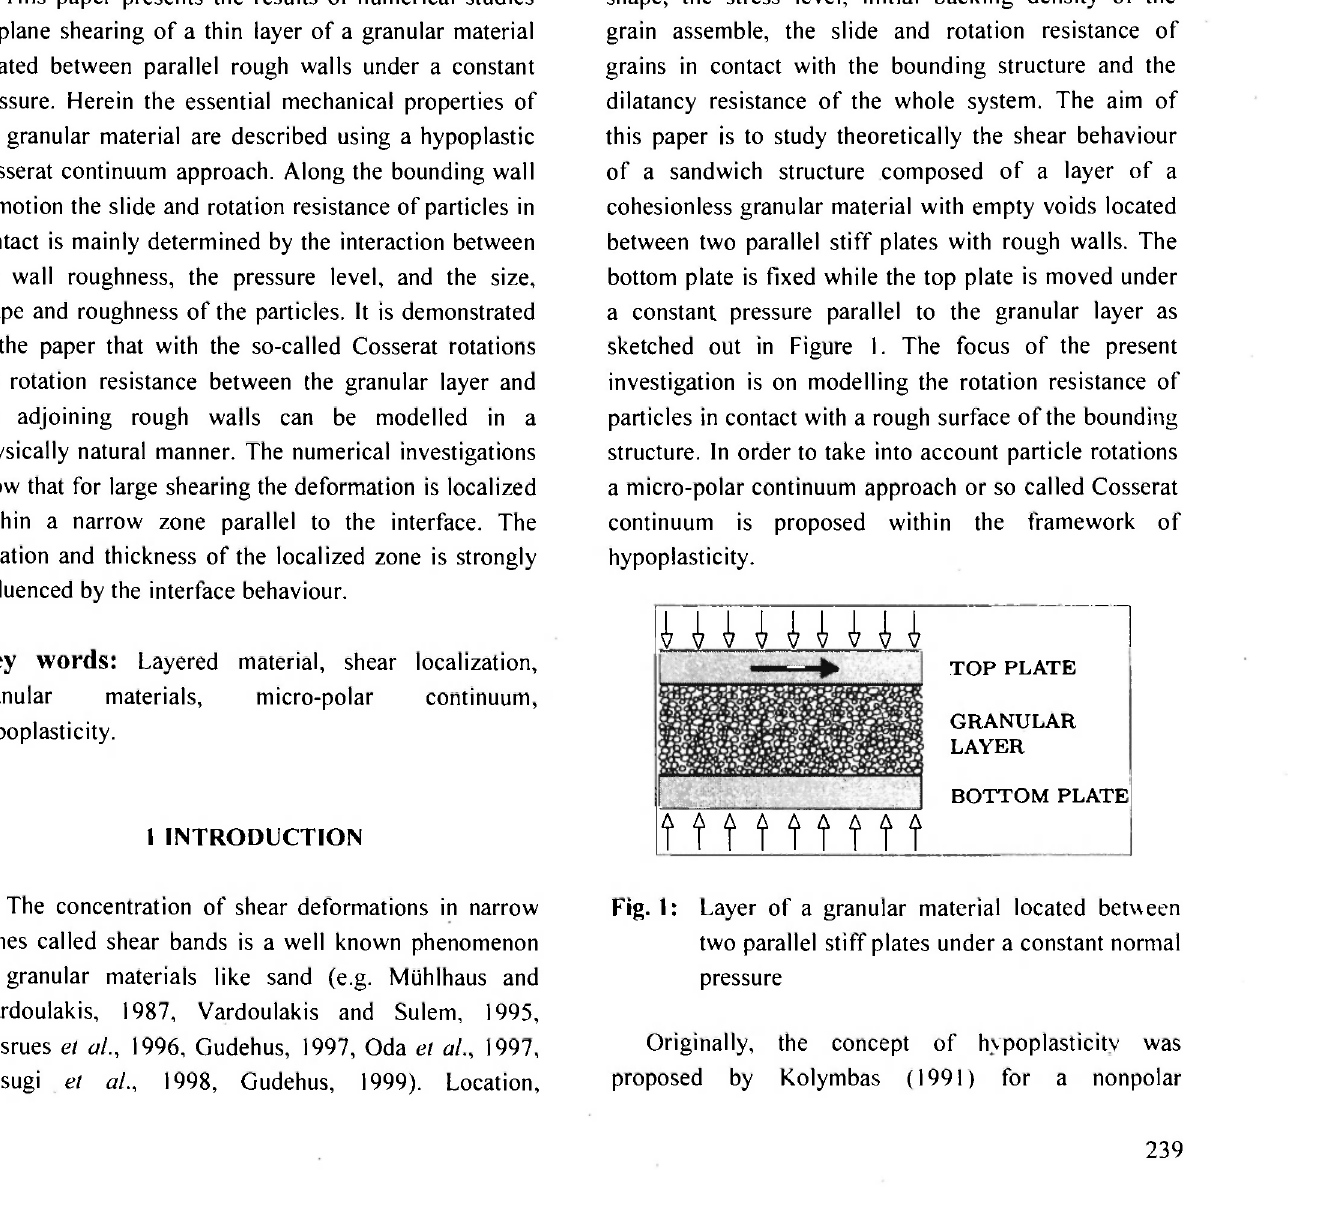
Fig. 1: Layer of a granular material located